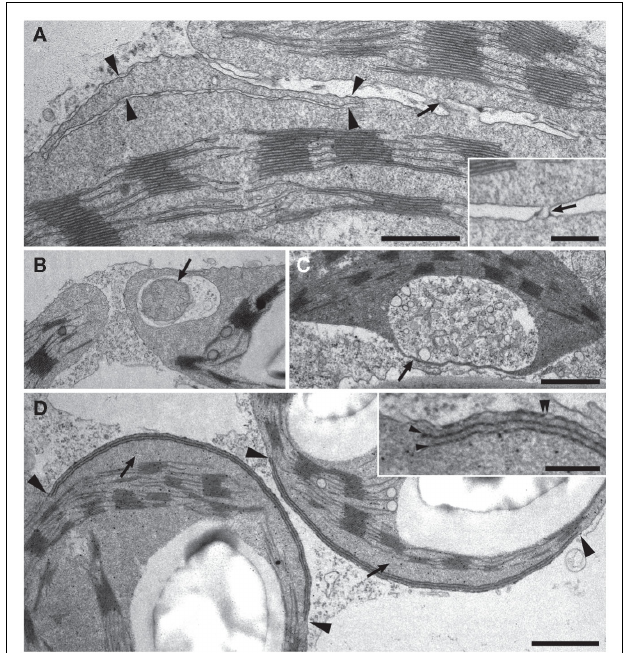
FIGURE 8 |Analysis of transient transfected N. benthamiana leave cells by transmission electron microscopy. Ultrastructural analysis of leave material of N. benthamiana plants transiently transfected with the constructs 35S:AtLACS9–GFP (A–C) or 35S:AtTIC40–GFP (D) . [ (A) ; and inset] Stroma filled connection sites (arrows) between chloroplasts in AtLACS9 transfected tobacco cells.The lower chloroplast displays a thin, stroma filled extension (arrowheads). Scale bar in (A) 0.5 μ m, scale bar in the inset: 0.2 μ m. (B) An AtLACS9–GFP containing chloroplast enclosing a mitochondrion (arrow) by a stroma filled extension. (C) A chloroplast of an AtLACS9–GFP expressing tobacco cell displaying a very thin, stroma filled tube. Scale bar in (C) [applies also to (B) ]: 1 μ m. [ (D) and inset] Chloroplasts of AtTIC40–GFP transfected tobacco cells displaying areas with layers of inner envelope membrane (between arrowheads).The inset shows a higher magnification of additional layers of inner envelope membrane (arrowheads). A double arrowhead labels the outer and inner envelope membranes in close proximity.The proliferated membrane withdraws from the thylakoid membrane and generates a thylakoid free area (arrows). Scale bar in (D) 1 μ m, scale bar in the inset: 0.25 μ